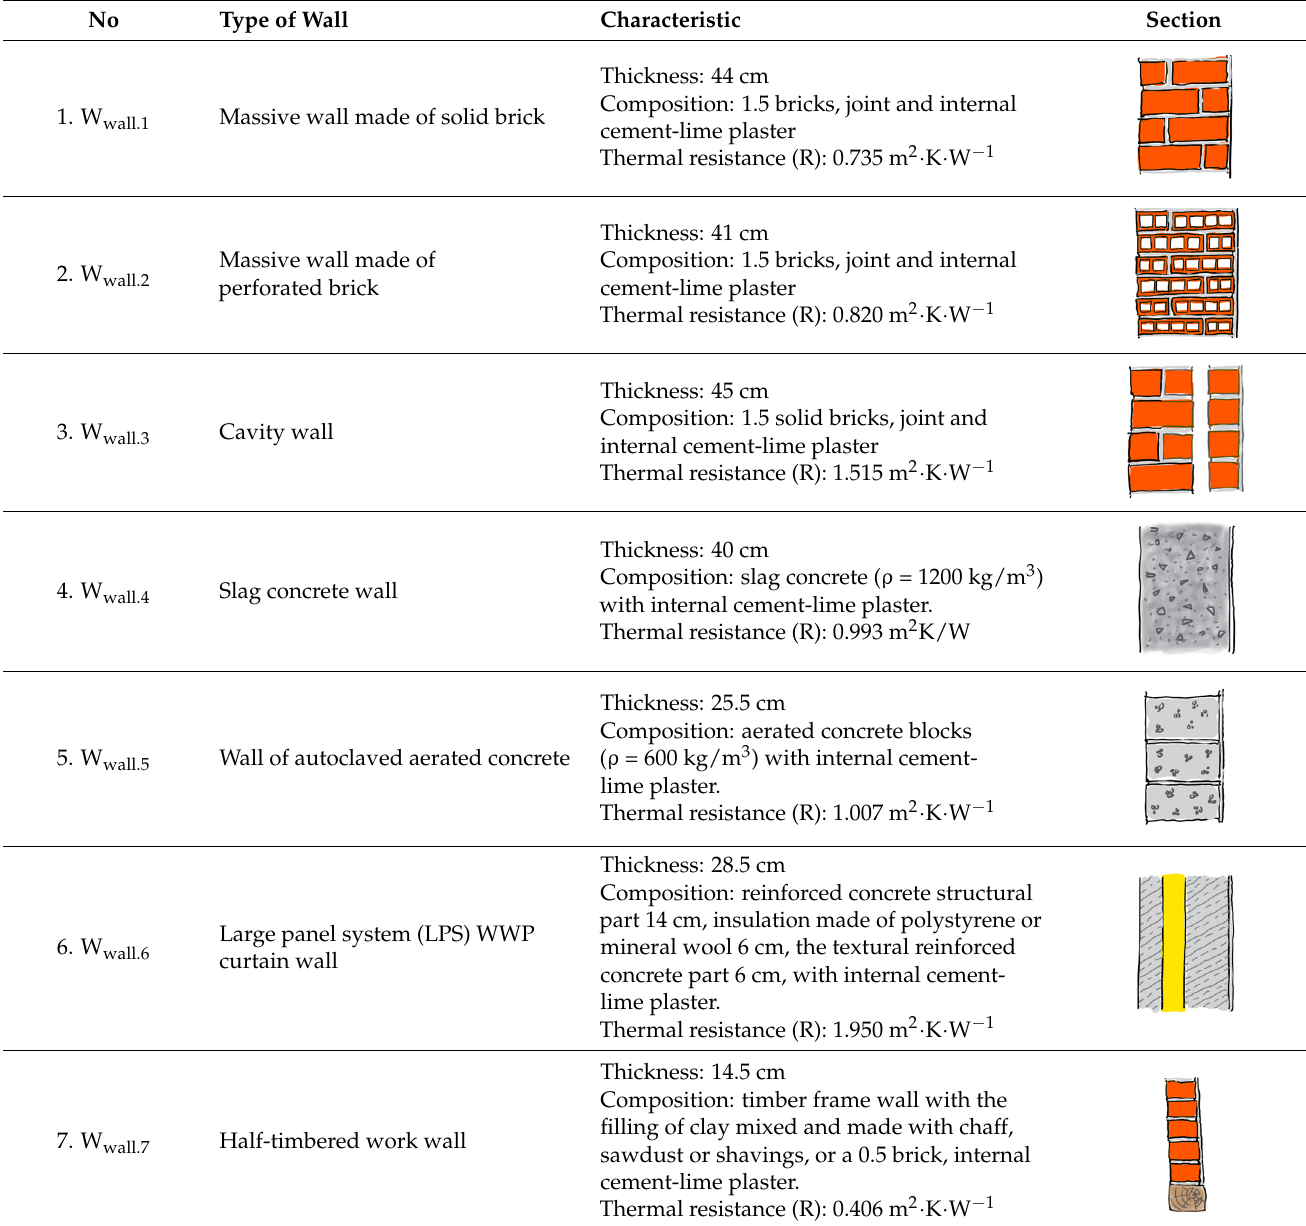
Table 5. Characteristics of existing walls.